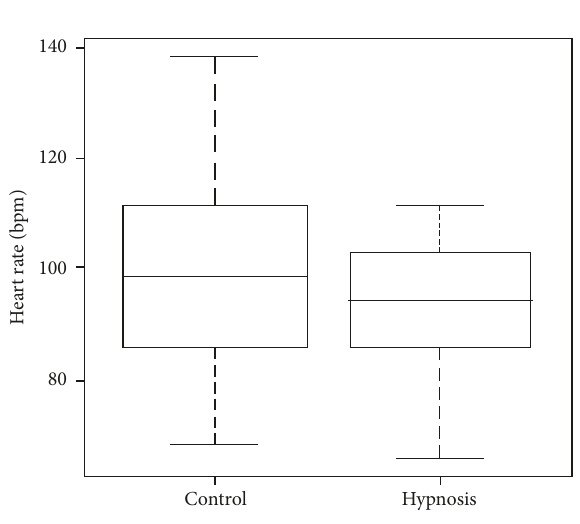
Figure 1: Comparison of the means of the heart rate of the groups to the anesthetic moment. Table2:Thismodeldeterminesthathypnosistherapyisthevariable that modifies the difference between heart rates. Dif HR ∼ hypnosis + age +